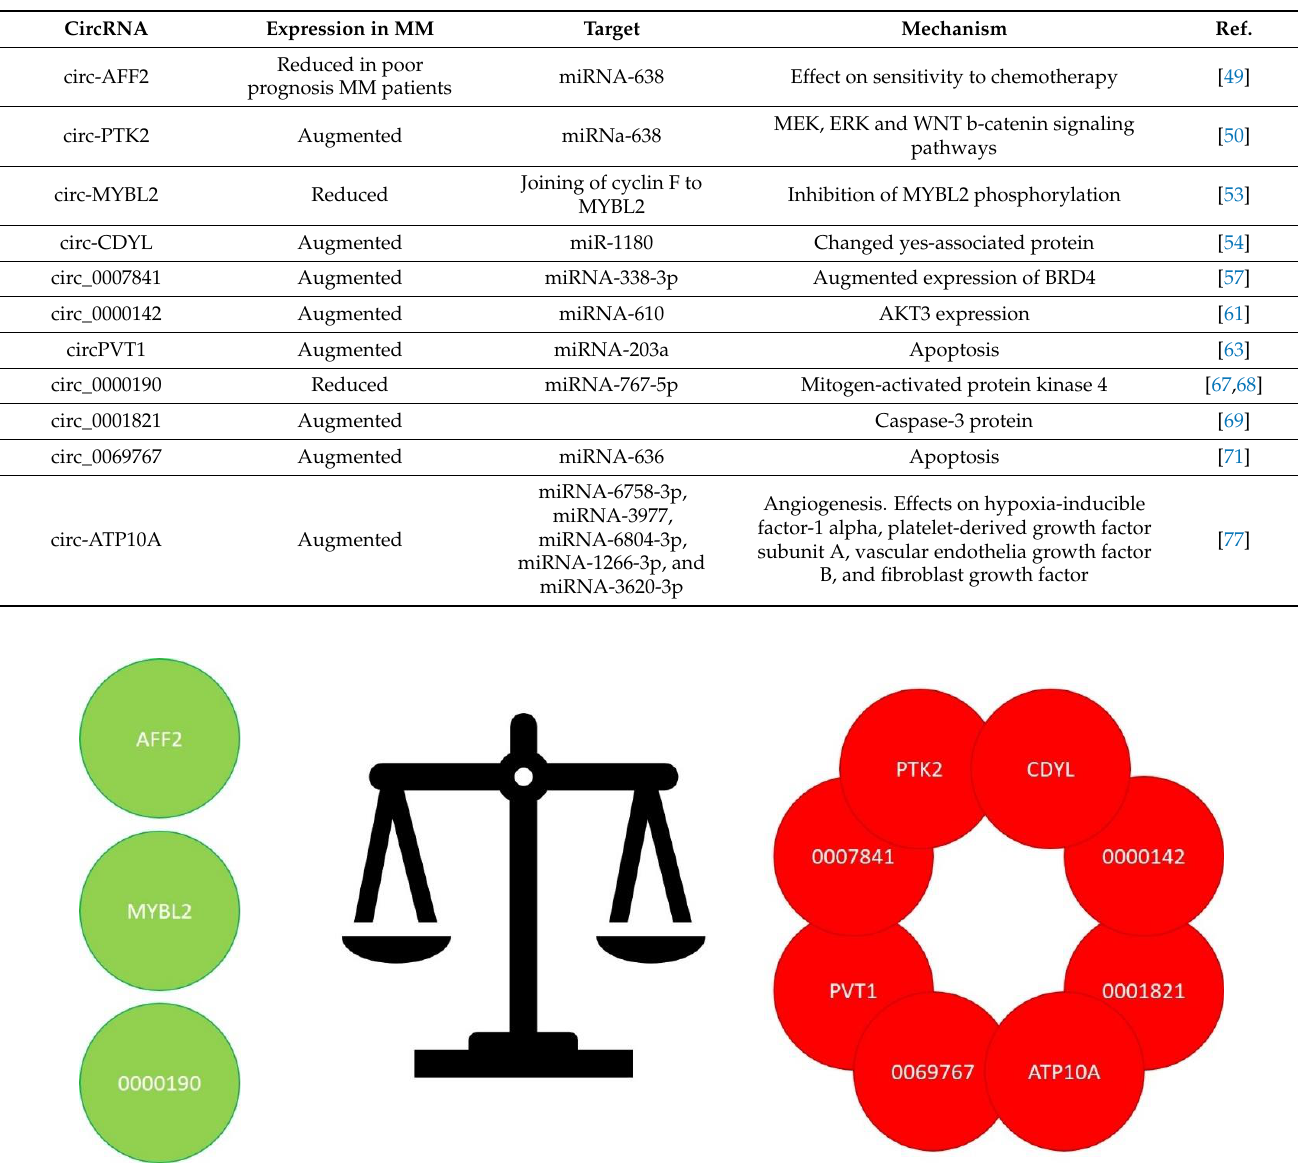
Table 1. Effects of circRNA in multiple myeloma.